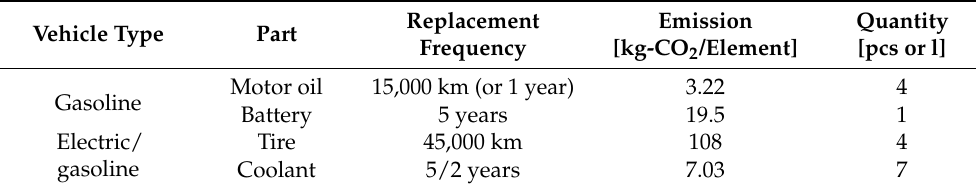
Table 3. Frequency of replacement of materials and consumable items during vehicle maintenance and their cumulative emissions based on Volkswagen data